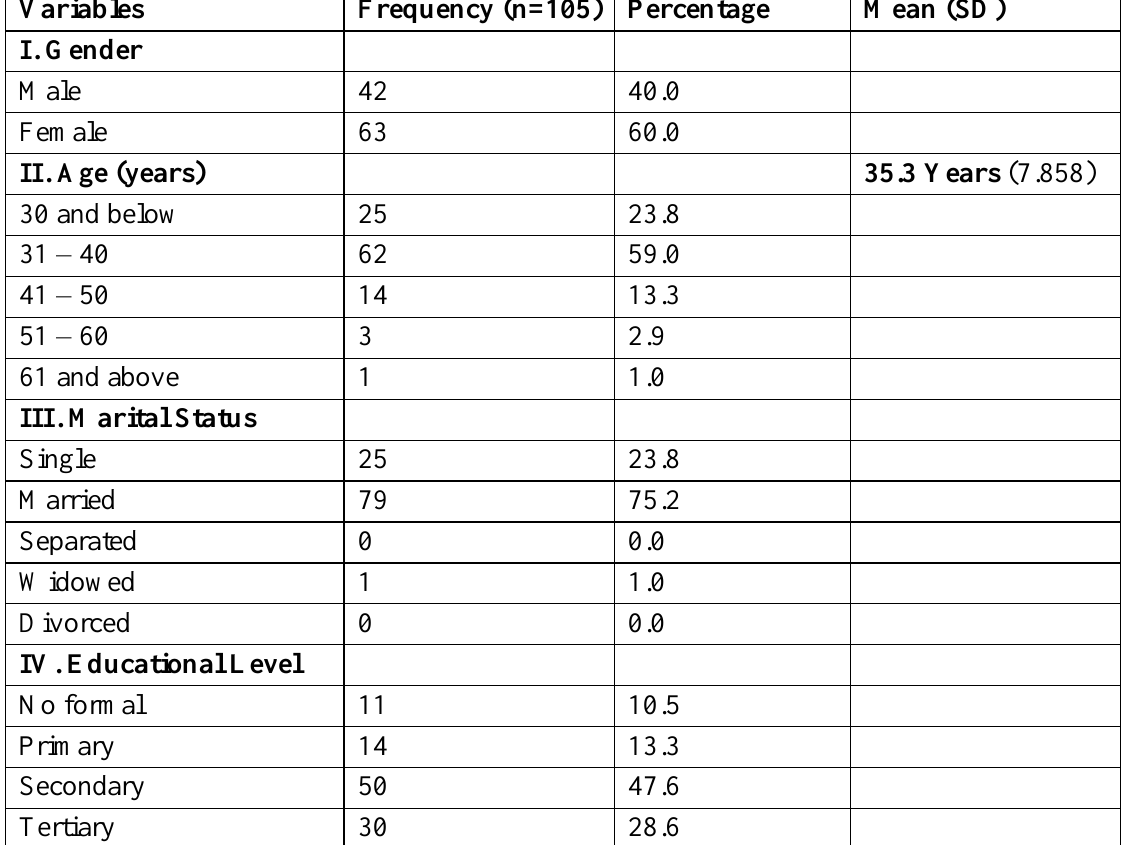
Table 1 . The Socio-economic Characteristics of the